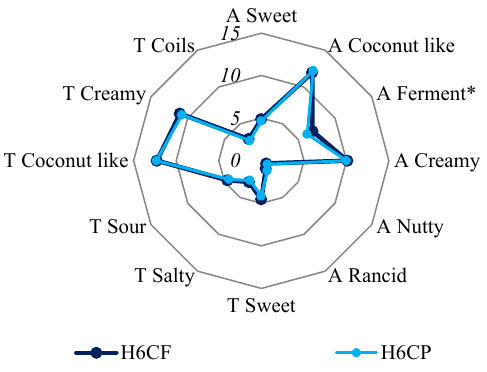
Figure 1 Descriptive analyse of aroma and taste of hybrid